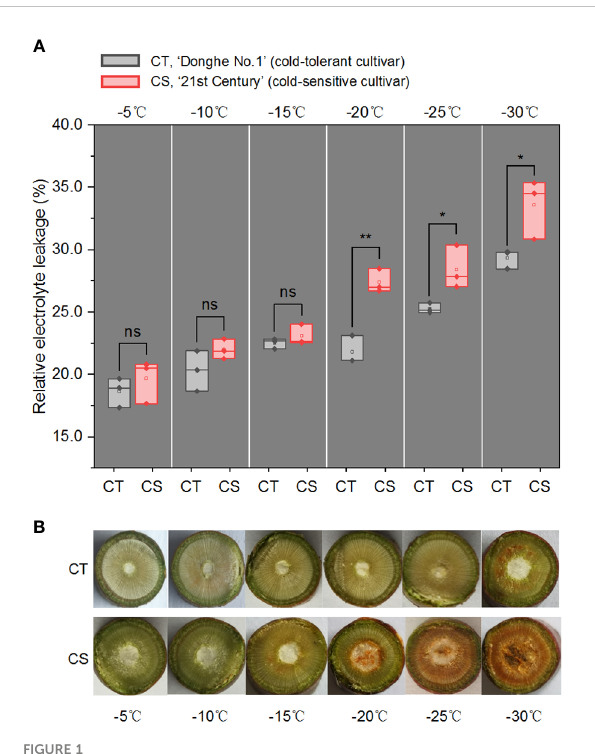
FIGURE 1 Relative electrolyte leakage and cross-section photos of peach branches under cold stress. (A) Relative electrolyte leakage (REL) of 1- year-old branches of CT and CS under cold stress for 12 h. CT, ‘ Donghe No.1 ’ (cold-tolerant cultivar); CS, ‘ 21st Century ’ (cold-sensitive cultivar, CS). ns, not signi fi cant; *p < 0.05; **p < 0.01. The p values were calculated using the t-test for the difference in electrolyte leakage rates (ELR). (B) Cross-section photos of CT and CS under cold stress for 12